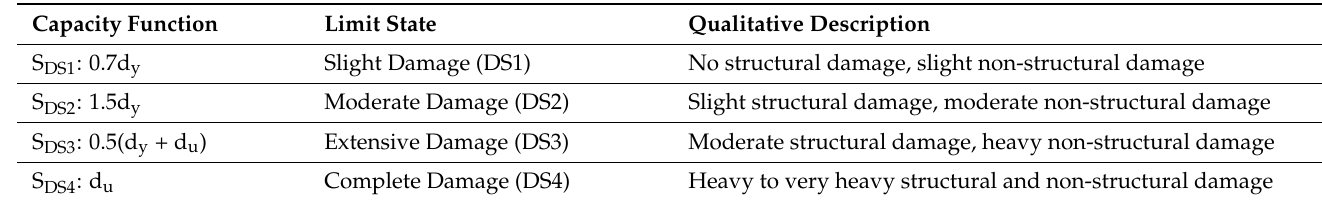
Table 5. Structural damage states considered for fragility analysis (after